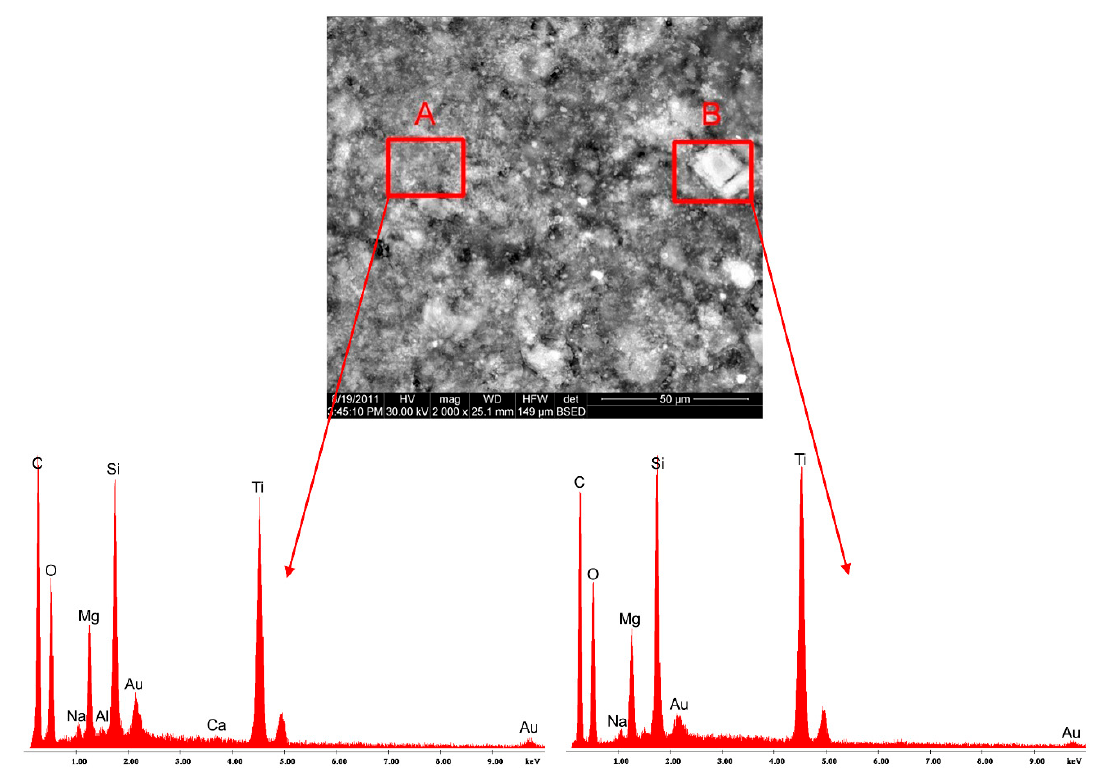
Figure 6. EDAX analysis of the MXA pellet surface.